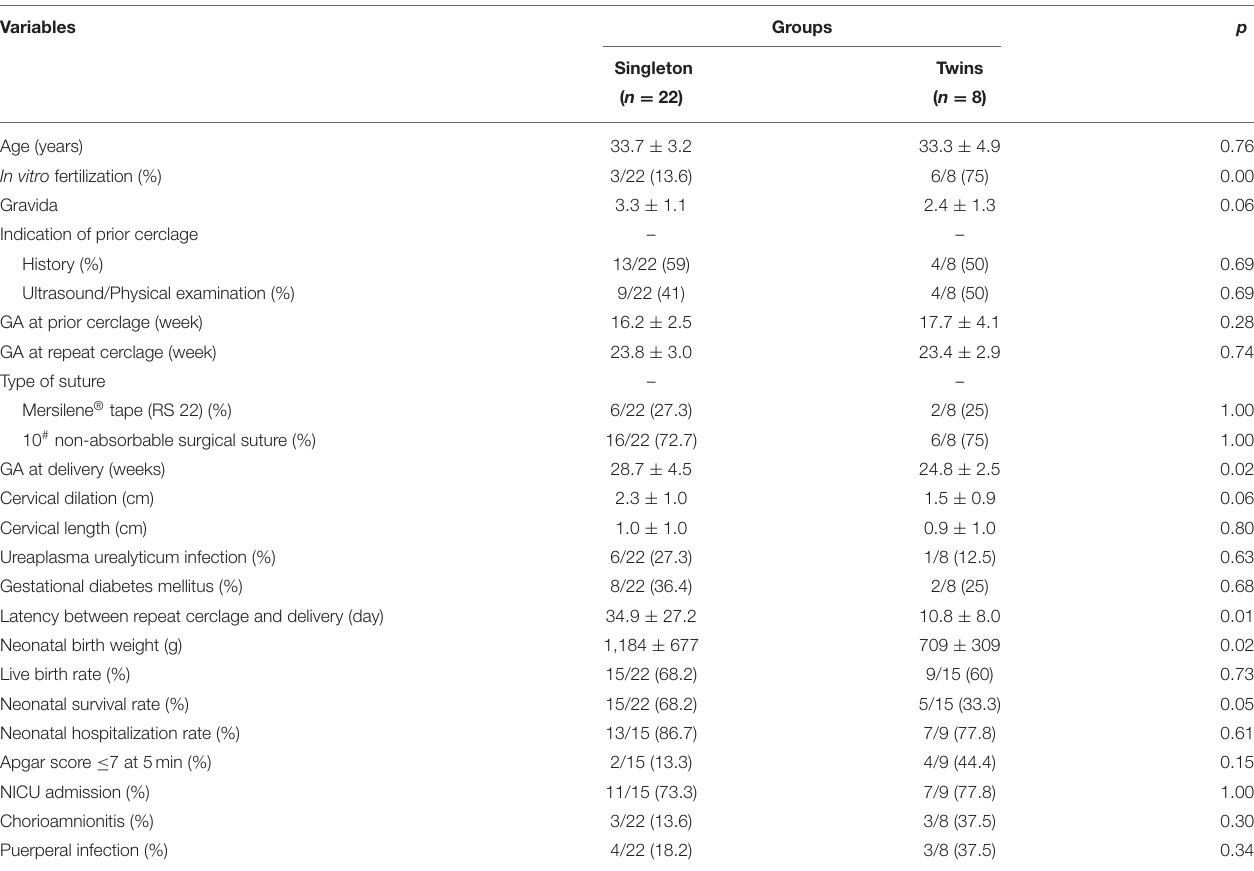
TABLE 1 | Comparison of clinical characteristics between patients with singleton and twin pregnancy.